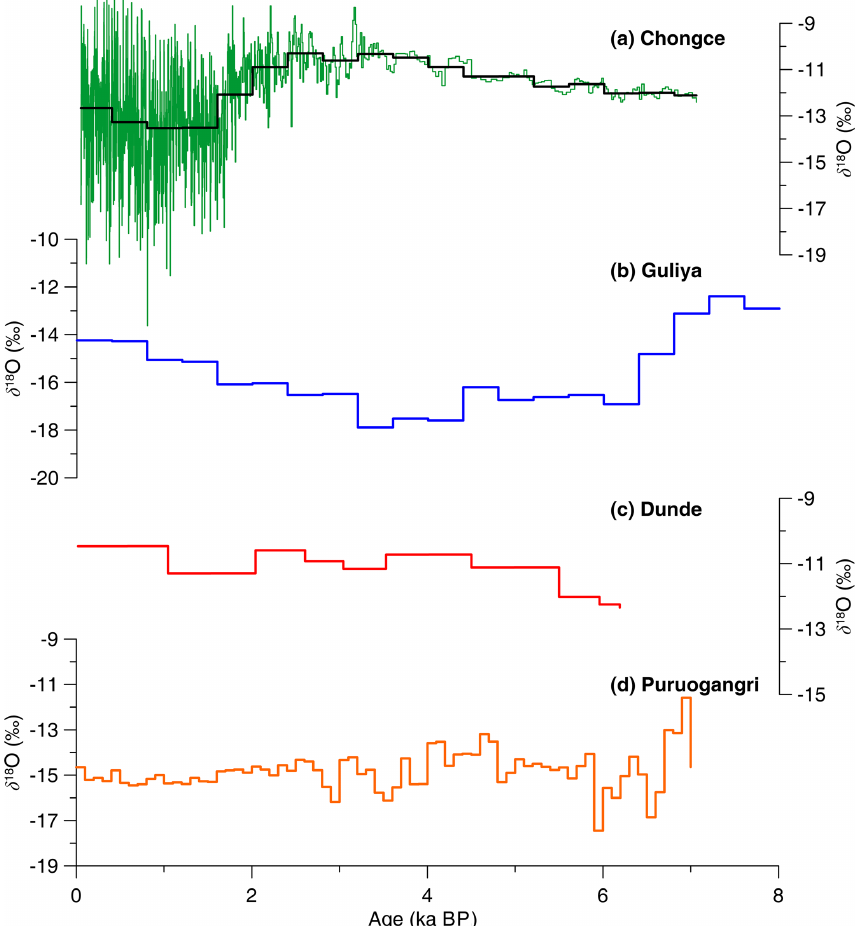
Figure 3. The δ 18 O profiles of the Chongce (a) , Guliya (b) , Dunde (c) and Puruogangri (d) ice cores by age. We combined the δ 18 O profiles of Core 2 and Core 3 into a single time series. The black line of the Chongce δ 18 O profile represents 400-year averages to match the temporal resolution of the Guliya ice core data that are available from the NOAA online repository. The 100-year averages of the Puruogangri ice core are also available from the NOAA online repository, but the multi-centurial averages of the Dunde ice core were extracted from Fig. 3 of Thompson et al. (2005), plotted based on its updated chronology instead of its original chronology (Thompson et al., 1989).